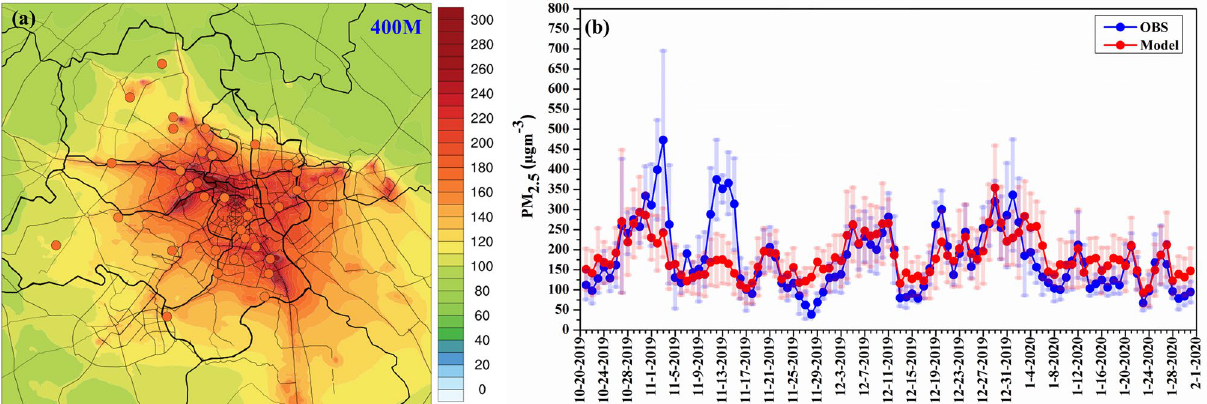
Figure 2. (a) Spatial distribution of averaged PM 2.5 concentrations at 400 m horizontal grid-spacing (from day 1 forecast) overlaid with mean PM 2.5 observed at different monitoring stations across Delhi during 21 October 2019 to 01 February 2020, (b) Comparisons between daily mean PM 2.5 forecast (red) and daily mean PM 2.5 observations (blue) over Delhi during 21 October 2019 to 01 February 2020 (vertical bar shows the standard